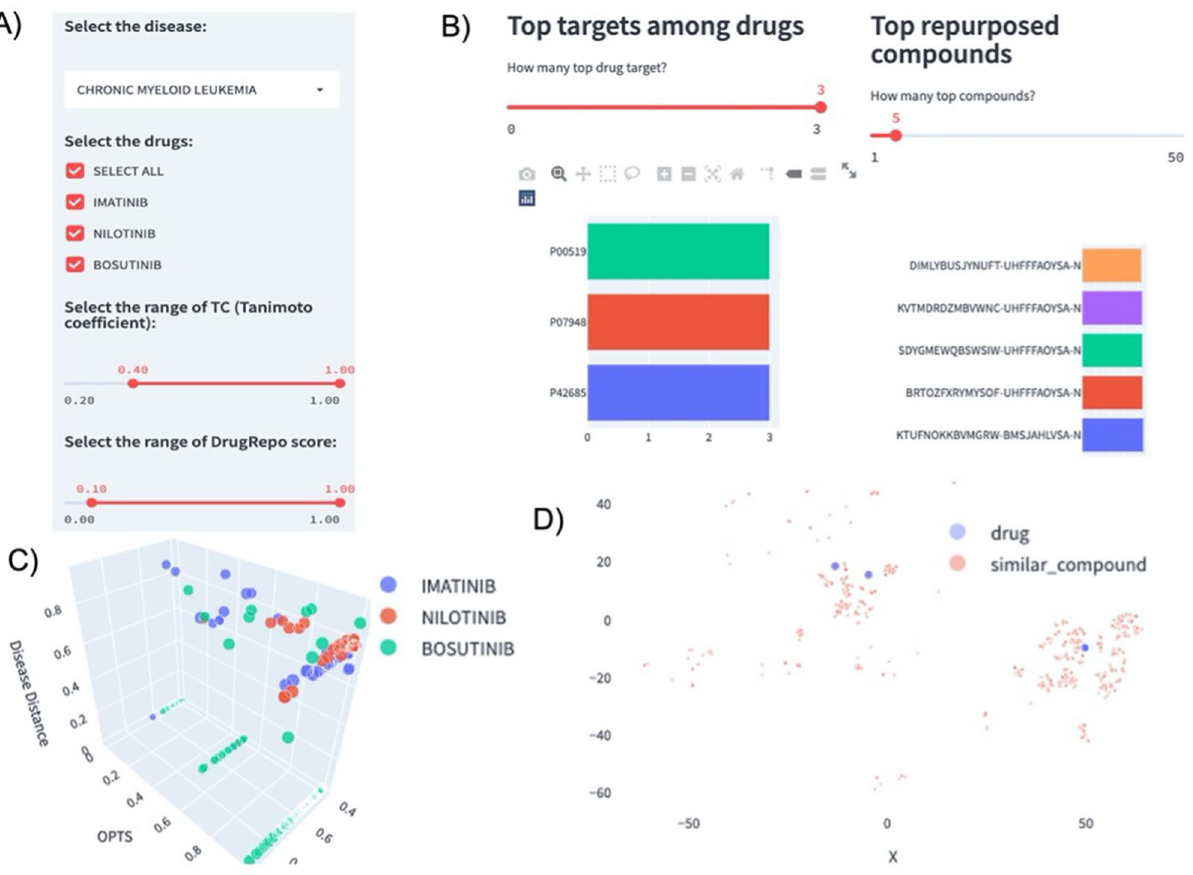
Figure 8. Using the DrugRepo GUI to repurpose drugs for CML. ( A ) Select disease interface, users can uncheck any of the approved drugs, modify TC, and DrugRepo thresholds, ( B ) Top targets for approved drugs and top repurposing/rescuing compounds, ( C ) Drug repurposing plot, each point is based on three scores for an approved drug and repurposing compound, ( D ) The 2D visualization for structural similarities between approved drugs and repurposing